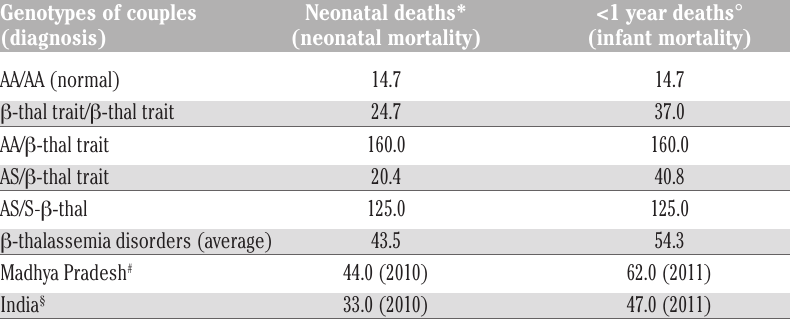
Table 3. Comparison of neonatal mortality and infant mortality rates of Madhya Pradesh and